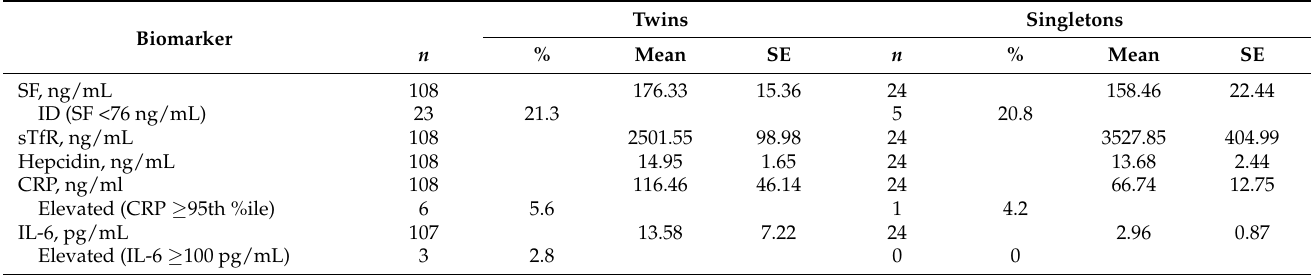
Table 2. Summary of iron biomarker values in neonates from twin and singleton